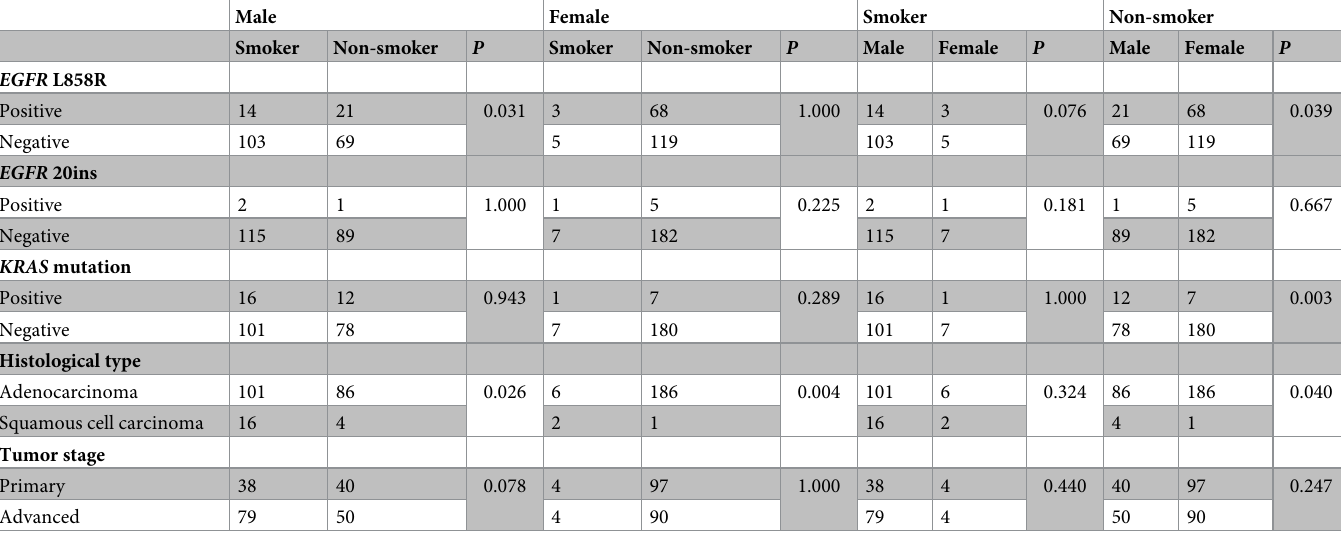
Table 6. Comparison of EGFR L858R, EGFR exon 20 insertion, KRAS mutation, histological type, and tumor grade between smoker and non-smoker in different gender, and between male and female patients in smokers or non-smokers.